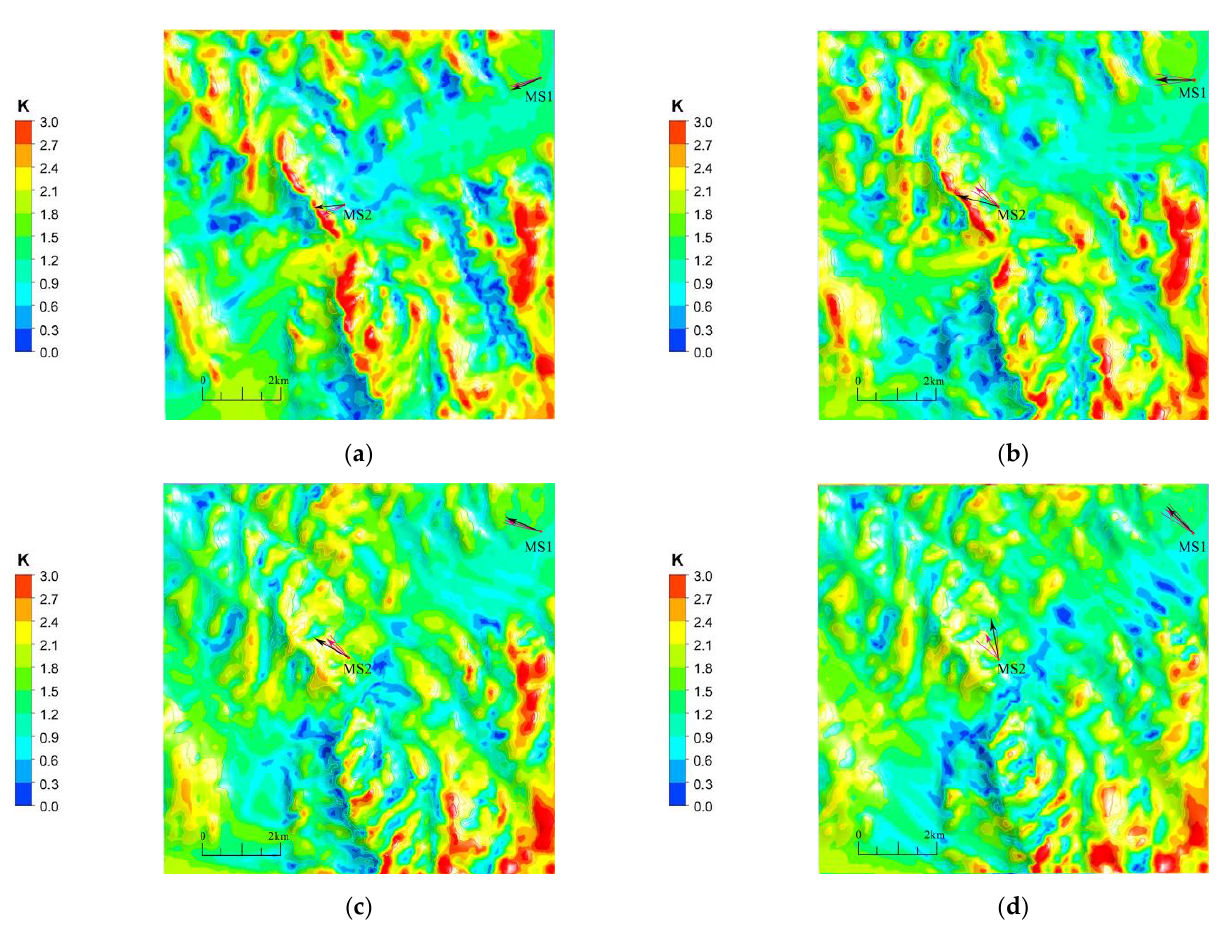
Figure 10. Colour contours of the simulated and measured wind speed ratio at 10 m height above ground ( a ) 67.5°; ( b ) 90°; ( c ) 112.5°; ( d ) 135°.